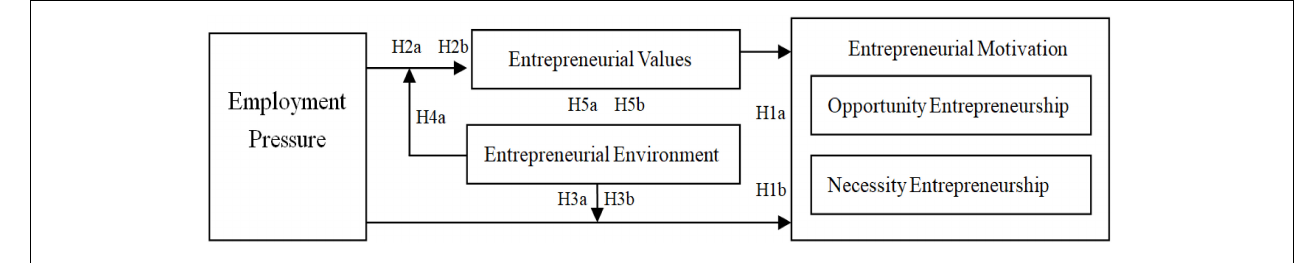
FIGURE 1 | Research